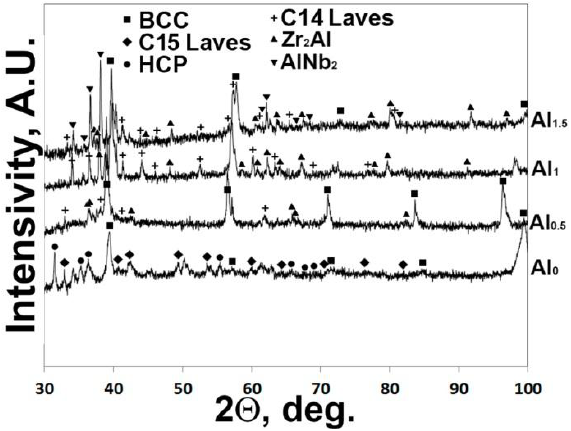
Figure 3. XRD patterns of the Al x NbTiVZr ( x = 0; 0.5; 1; and 1.5) alloys after annealing at 1000 ◦ C for 100 h.